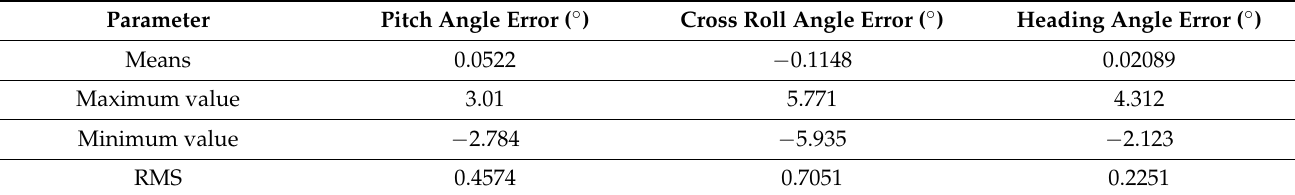
Table 3. Flight test attitude error.